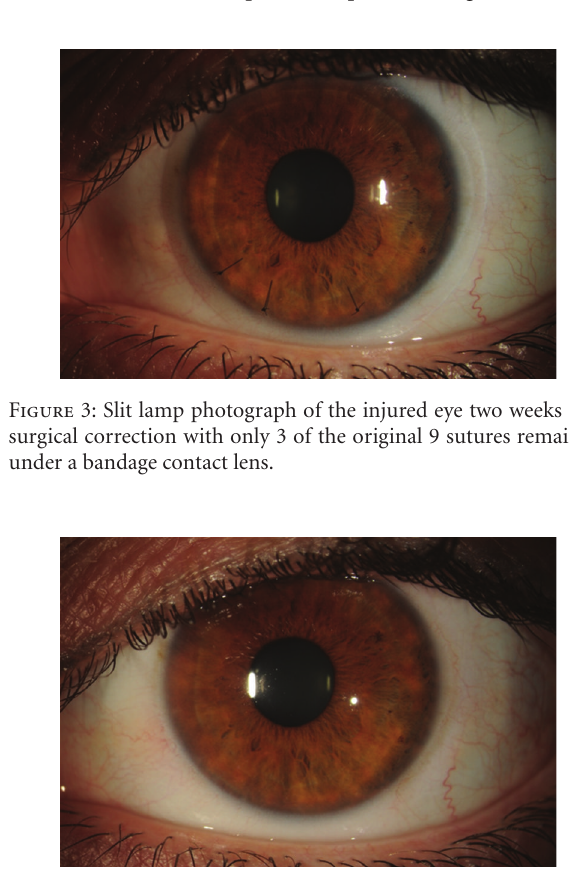
Figure 2: Slit lamp photograph of the injured eye one week after surgical correction with 3 sutures removed.